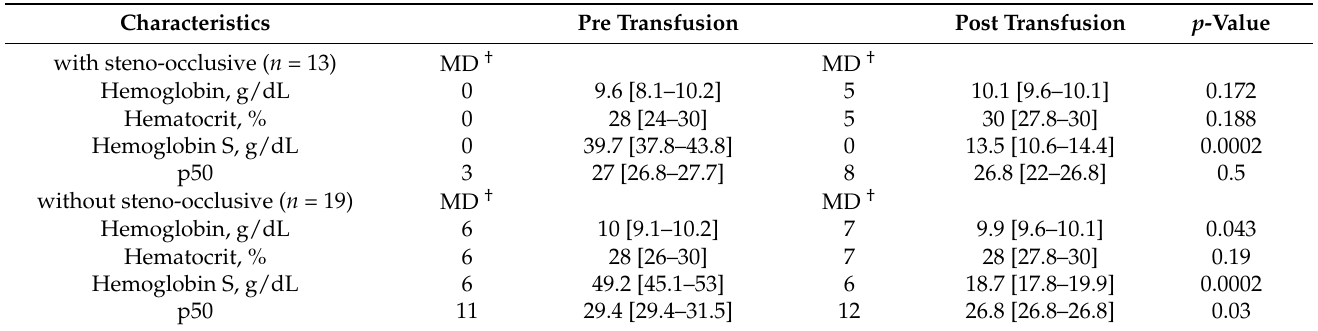
Table 2. Main biological variables from patients with SCD according to their cerebral steno-occlusive arterial disease status. † Missing data